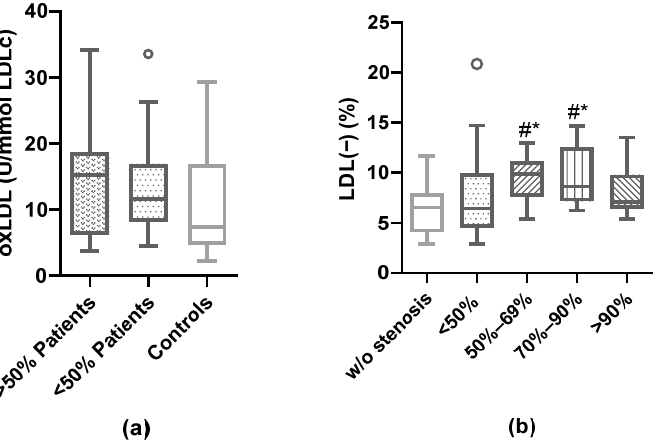
Figure 3. Concentration of oxLDL and LDL( − ) according to stenosis degree. Serum oxLDL levels were measured by ELISA and plasma LDL( − ) proportion was quantified by anion-exchange chromatography. ( a ) Levels of oxLDL when the patients were divided into groups of >50% stenosis and <50% stenosis. ( b ) Proportion of LDL( − ) stratifying by degree of carotid stenosis ( w / o stenosis n = 27, <50% n = 27, 50– 69% n = 13, 70–90% n = 12, >90% n = 10), Kruskal–Wallis test was performed ( p = 0.0017), # vs. controls (w/o stenosis); * vs. <50% patients; p < 0.05.